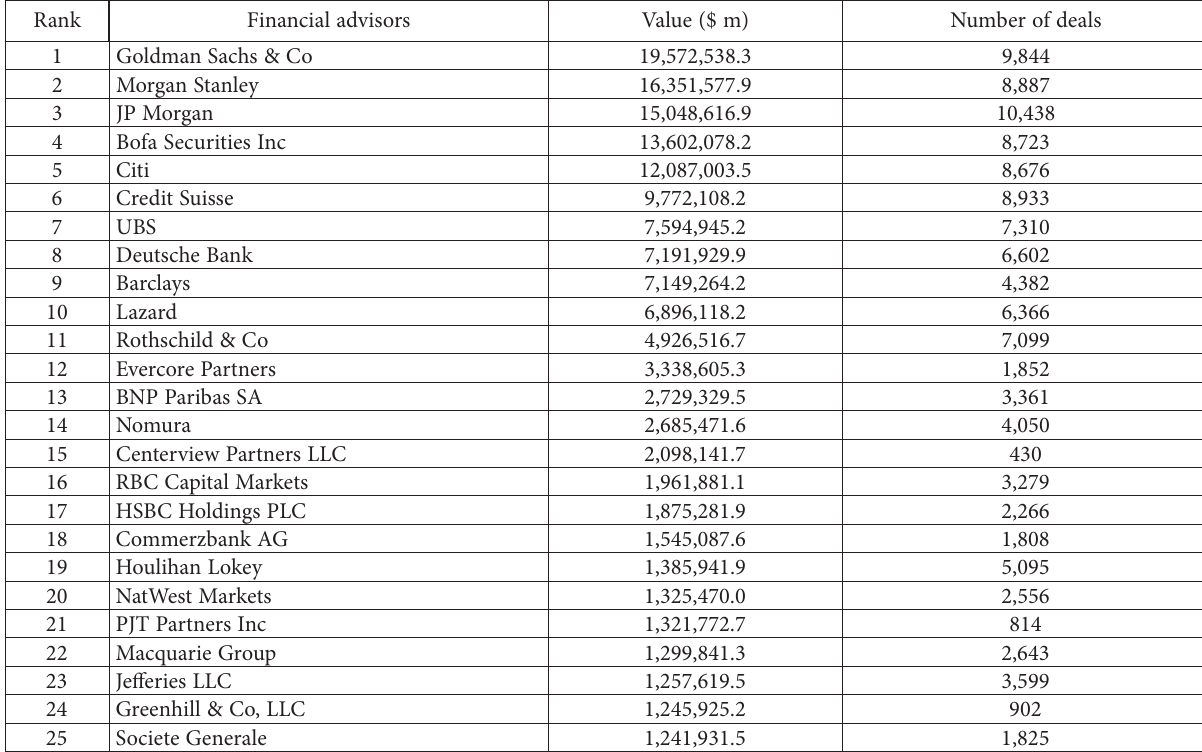
Table 1. Investment bank league table by total transaction value (all